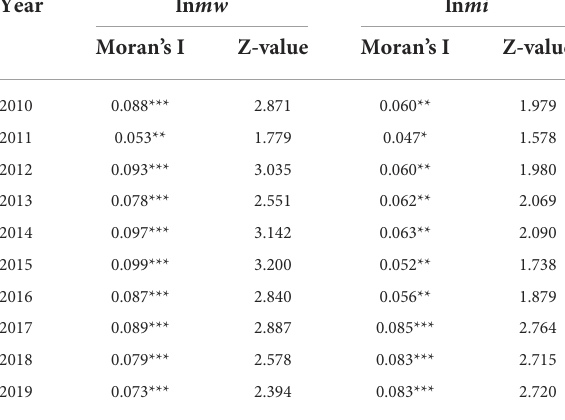
TABLE 3 Calculation of Moran’s I index of health care